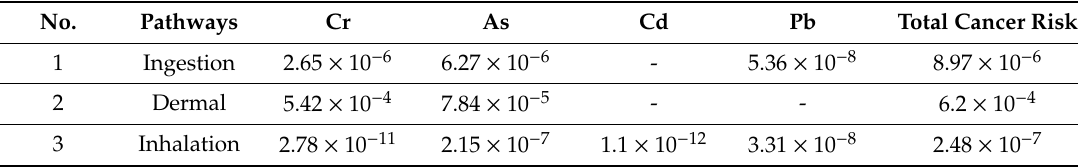
Table 11. Results of cancer risk for children.